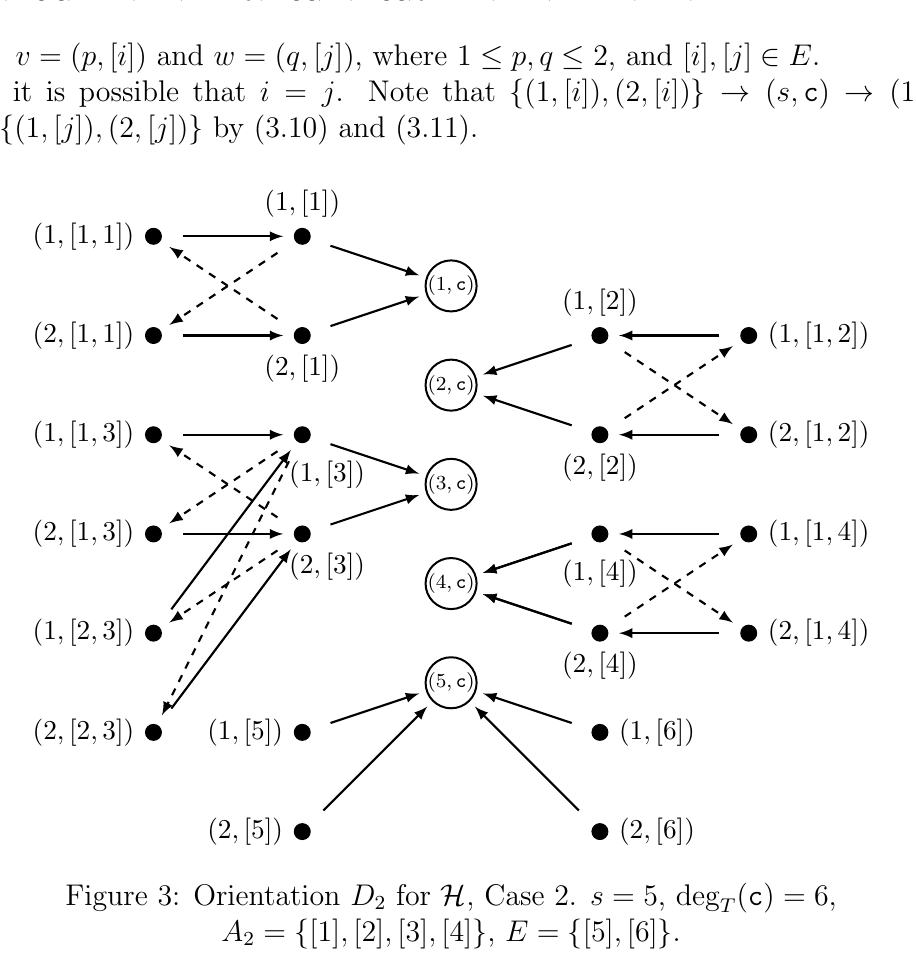
for H , Case 2. s = 5, deg 2